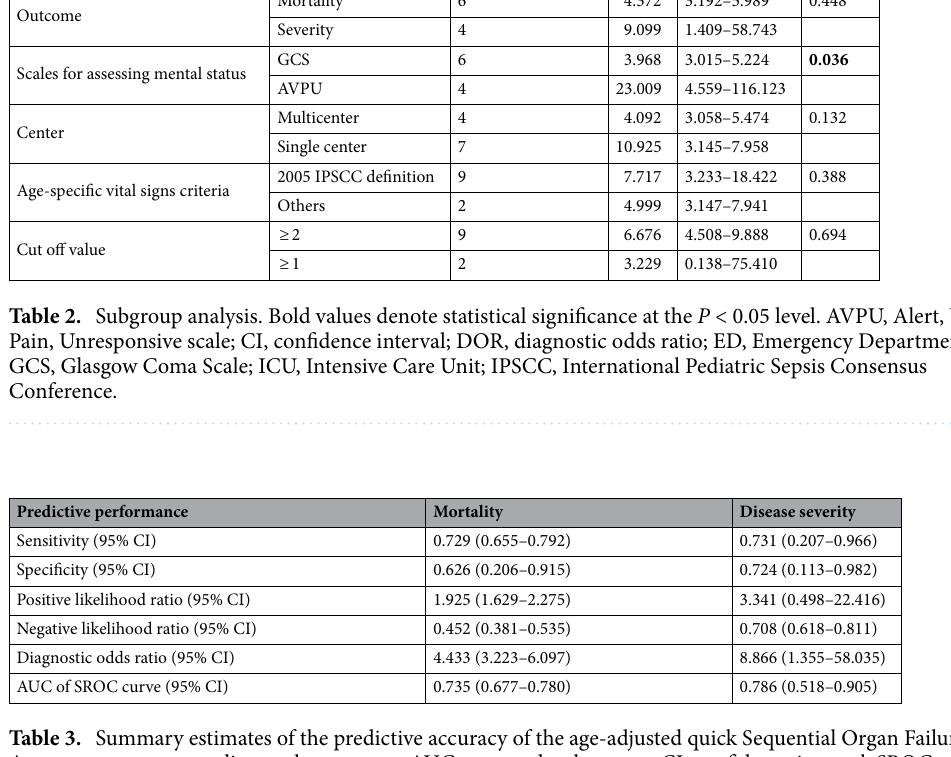
Table 3. Summary estimates of the predictive accuracy of the age-adjusted quick Sequential Organ Failure Assessment score according to the outcome. AUC, area under the curve; CI, confidence interval; SROC, summary receiver-operating